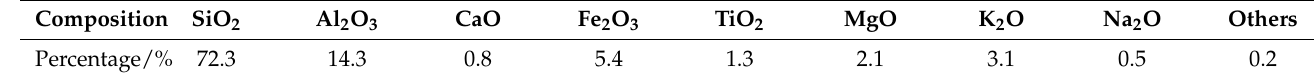
Figure 1. Gradation curve of soil. Table 1. The characteristic parameters of the tested soil.